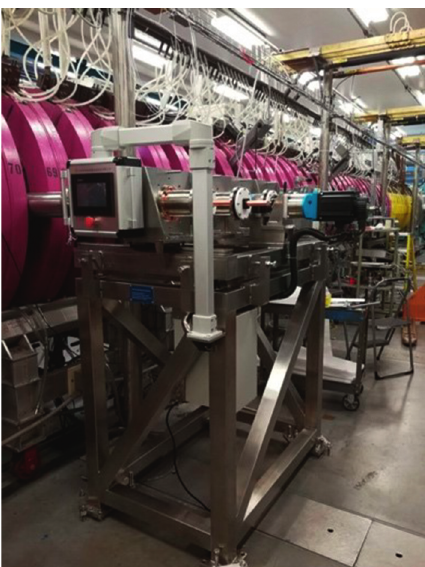
Figure 11: HHFW antenna integration with